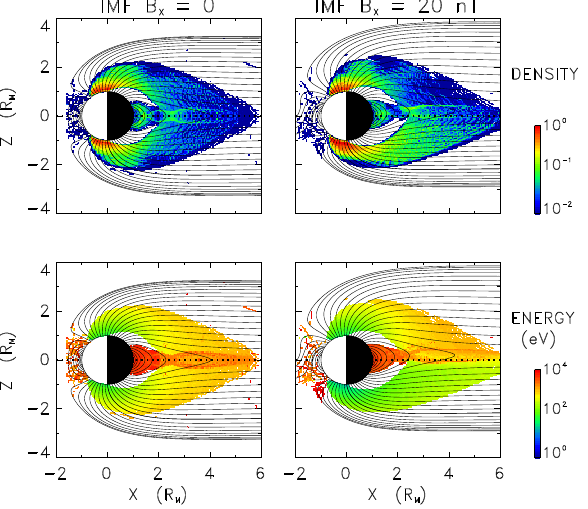
Fig. 6. (top) Model normalized density and (bottom) average energy of Na + ions in the noon-midnight meridian plane for (left) IMF B X = 0 and (right) IMF B X = 20nT. Density and energy are coded according to the color scales at right.